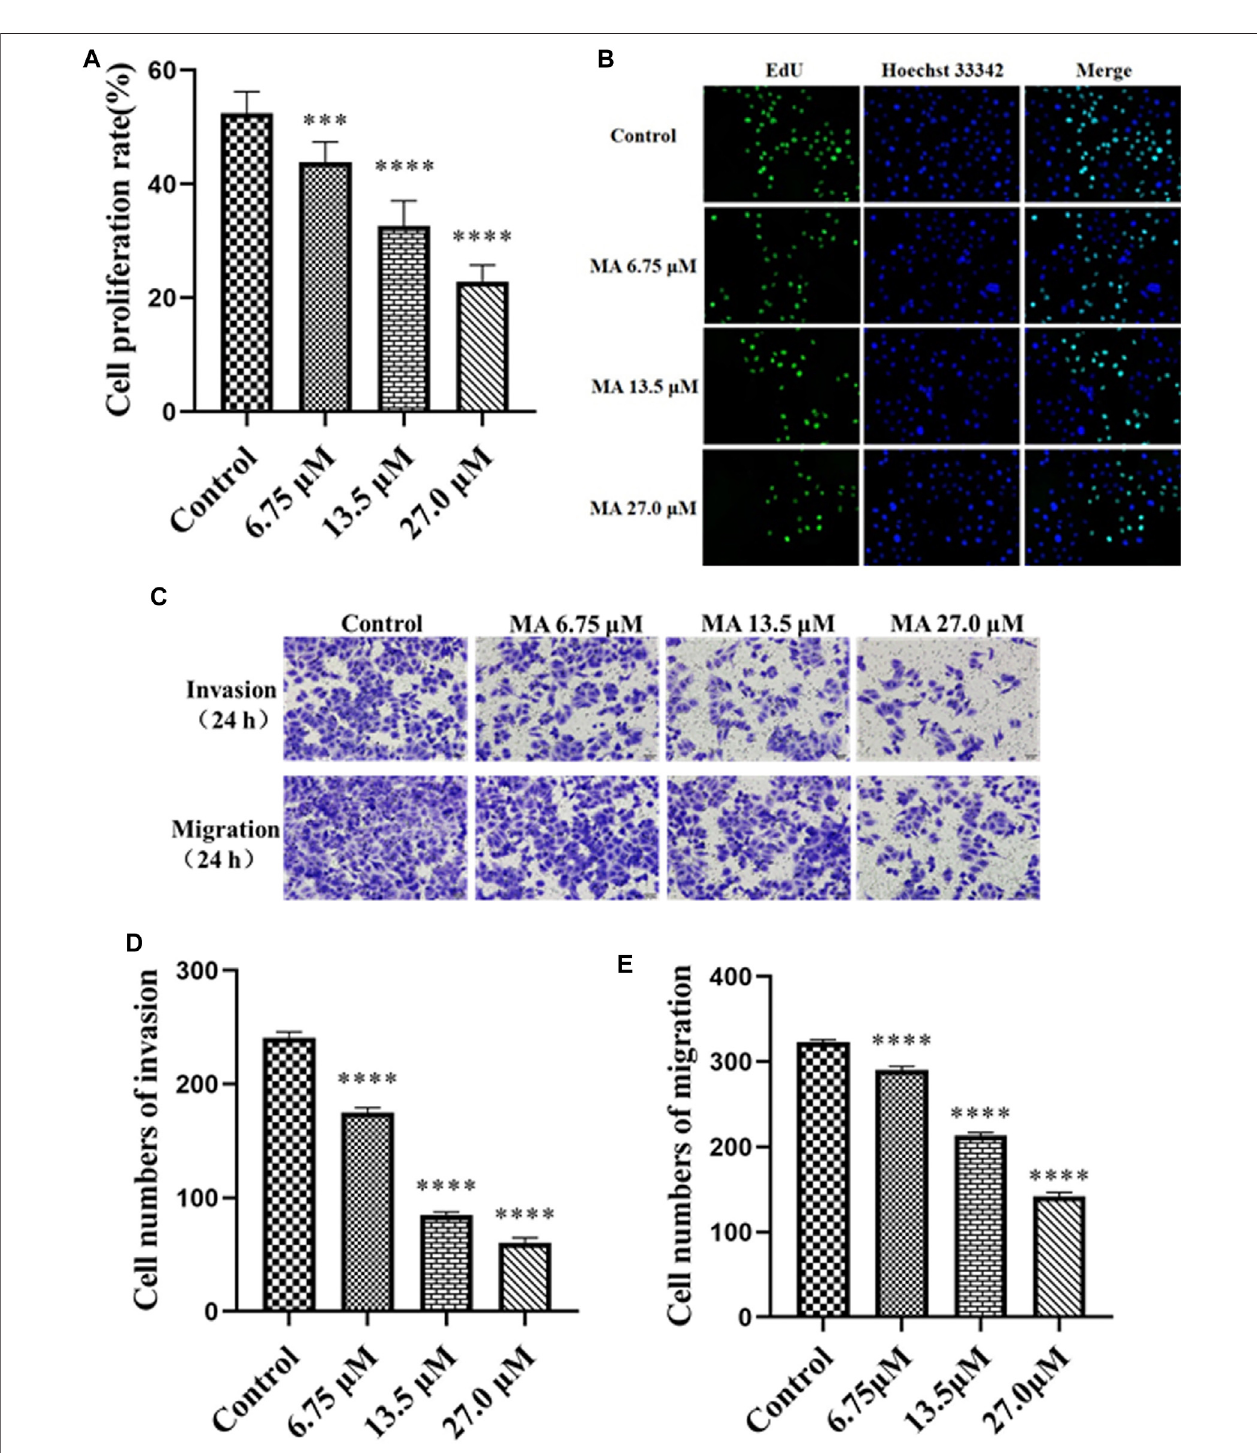
FIGURE2| MAinhibitstheproliferation,invasion,andmigrationofHeLacells. (A) TheproliferationrateofcellstreatedwithMA. (B) ImagesbyEdUassay:cellsDNA (blue) stained with Hoechst 33,342 (ab145597), green color revealed EdU/Hoechst-positive cells. (C) Images of cell invasion and migration by transwell assay. (D) The quantitative analysis of the cell invasion. (E) The quantitative analysis of the cell migration. Control represents the blank control group without any treatment. The results obtained from triplicate experiments (independent) are represented as mean ± SD (magni fi cation × 200; relative to the control group, *** p < 0.001, **** p < 0.0001).